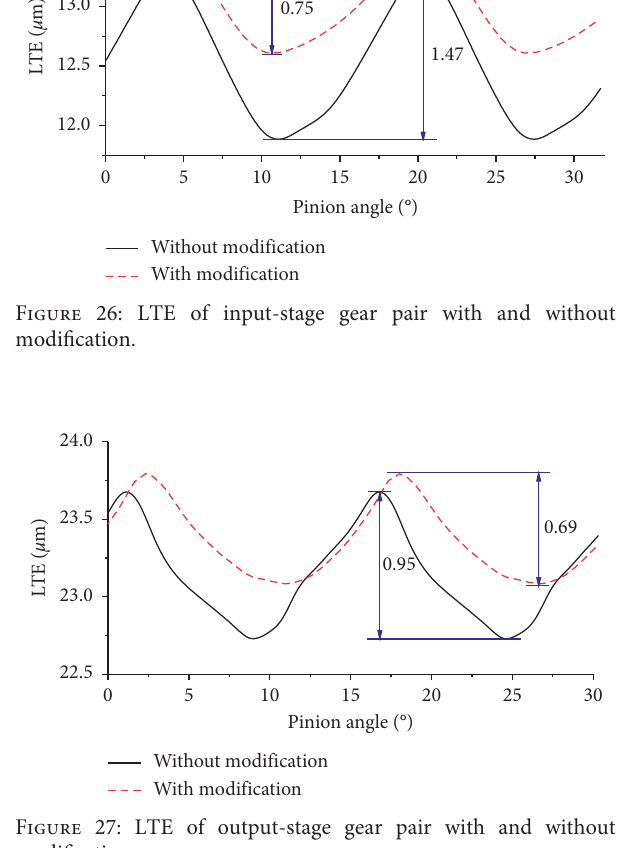
Figure 23: Model of the PEV reducer.